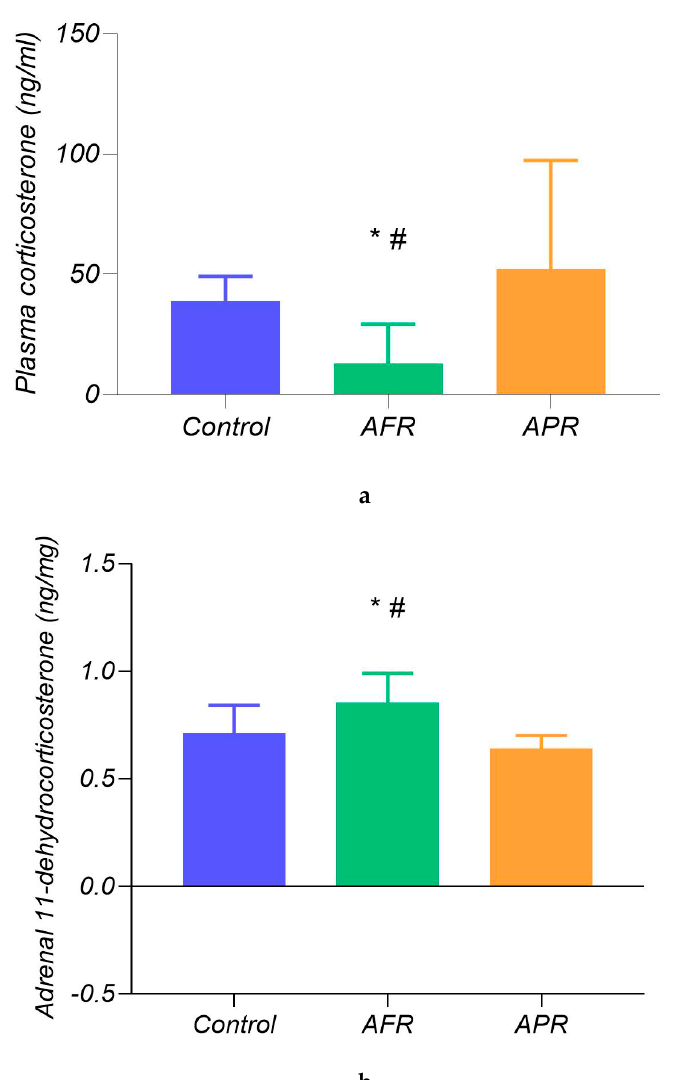
Figure 3. Comparison of peripheral corticosteroids 18 days after PSS. Legend: ( a ) Plasma CORT levels (ng / mL) and ( b ) adrenal 11-dehydrocorticosterone levels (ng / mg of tissue). # p < 0.05 AFR ( n = 9) in comparison to APR ( n = 12).); * p < 0.05 in comparison to control ( n = 8).